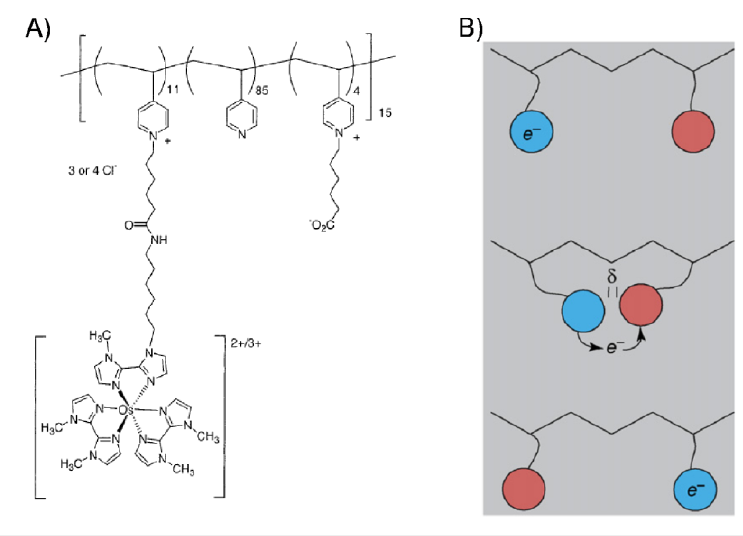
Figure 3. (A) Structure of anodic Os polymer with a 13-atom flexible spacer between the polymer backbone and the Os complex. Reprinted with permission from [86]. Copyright 2002 American Chemical Society. (B) Schematic presentation of electron conduction in Os redox hydrogels. Reprinted from reference [91] with permission from